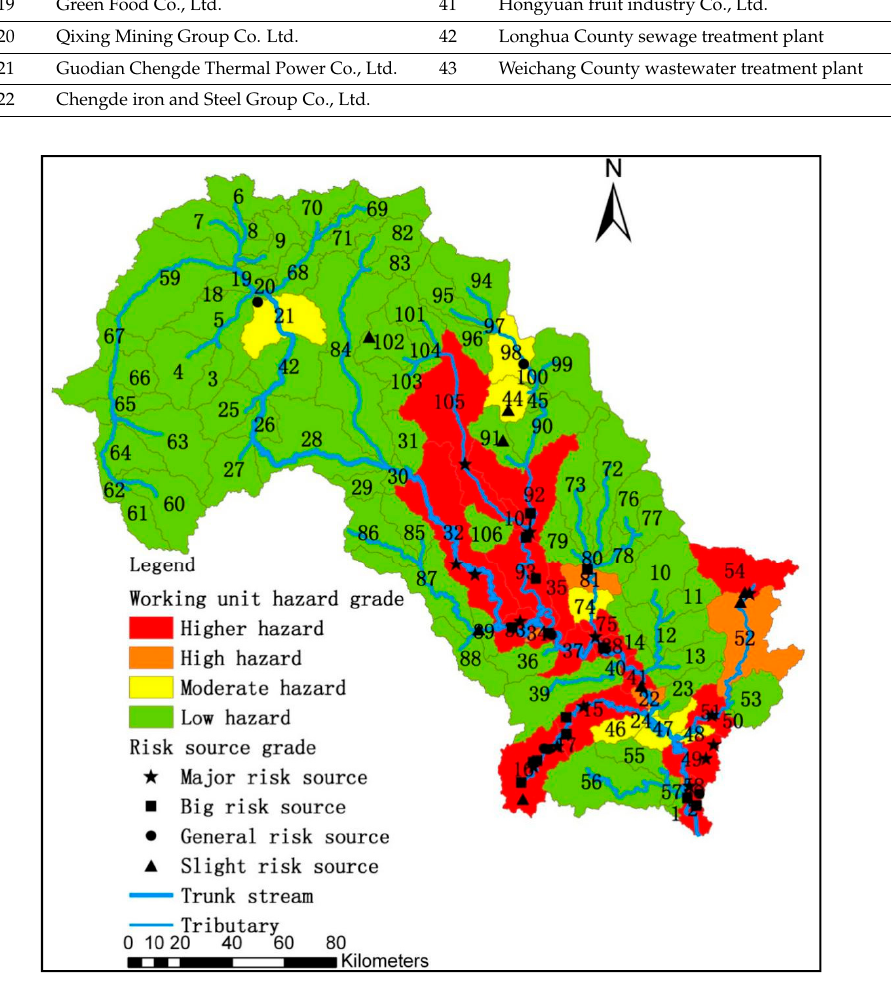
Figure 9. Working unit hazard grade distribution map.